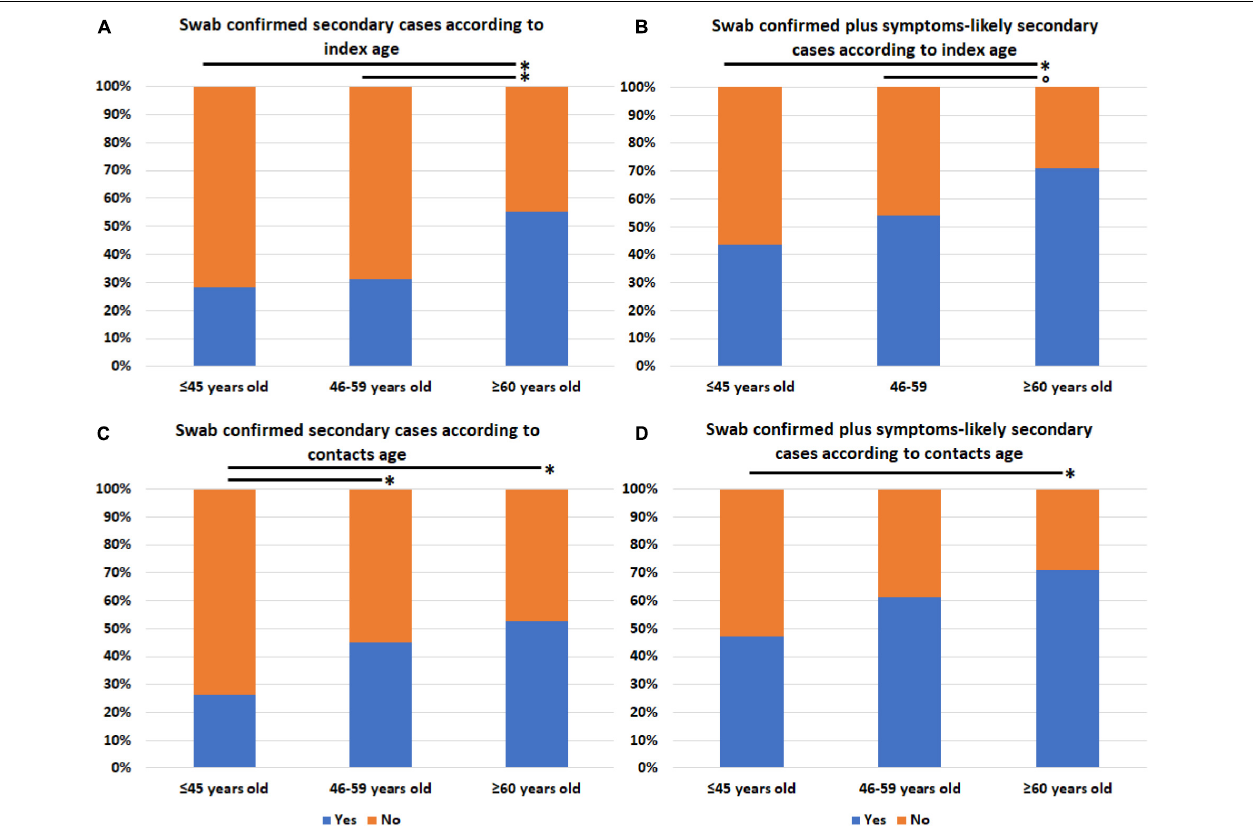
FIGURE 2 | Prevalence of secondary SARS-CoV-2 infections among household contacts according to age of either linked index cases or contacts. (A) Swab-confirmed secondary cases among all the household contacts according to index case age. (B) Swab-confirmed plus symptoms-based likely positive secondary cases among all the household contacts according to index case age. (C) Swab-confirmed secondary cases among all the household contacts according to contacts’ age. (D) Swab-confirmed plus symptoms-based likely positive secondary cases among all the household contacts according to contacts’ age. ∗ p -value ≤ 0.05; trend for statistical significance, p -value of